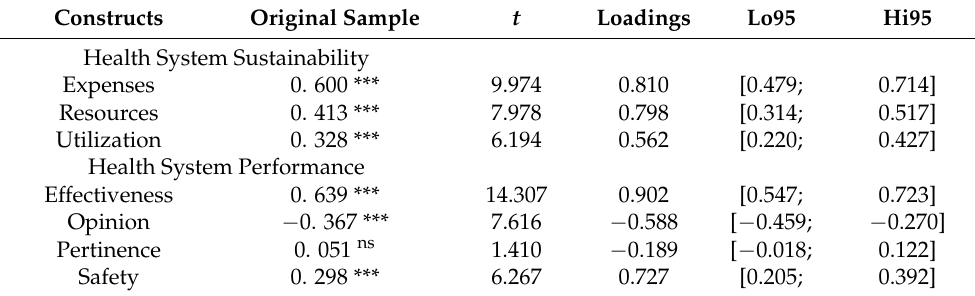
Table 8. Significance of weights.